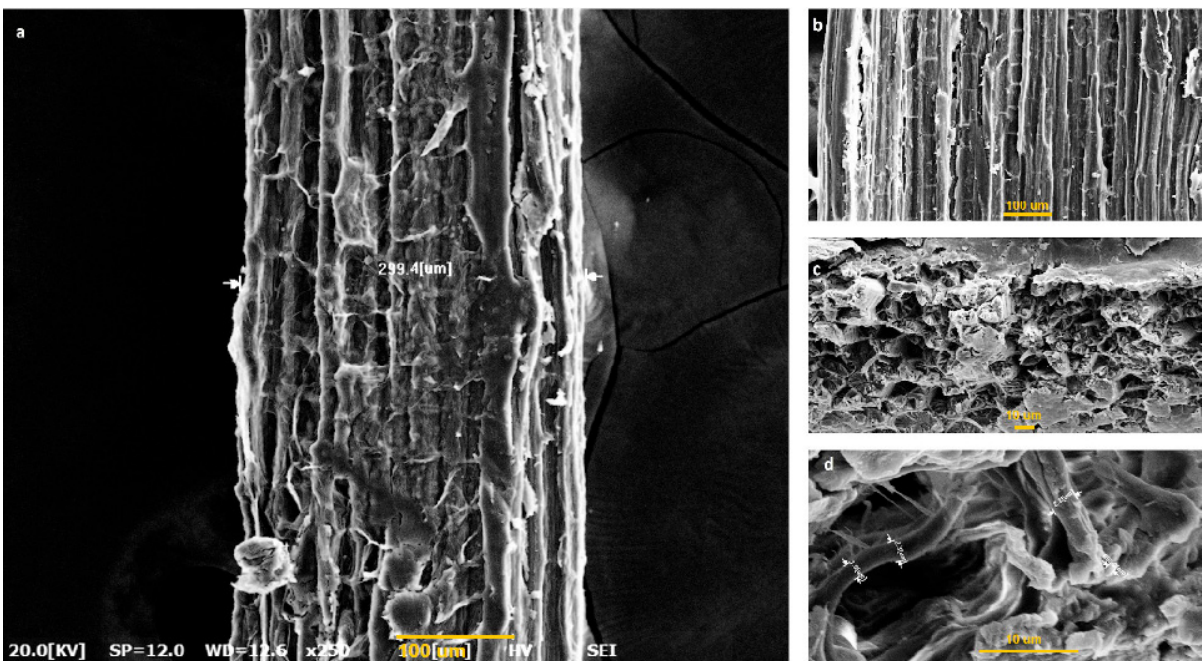
Figure 2. SEM images of Catalpa bignonioides fiber: ( a , b ) longitudinal view of the fiber (×250); ( c , d ) cross-section of the fiber (×1.0k and ×5.0k).